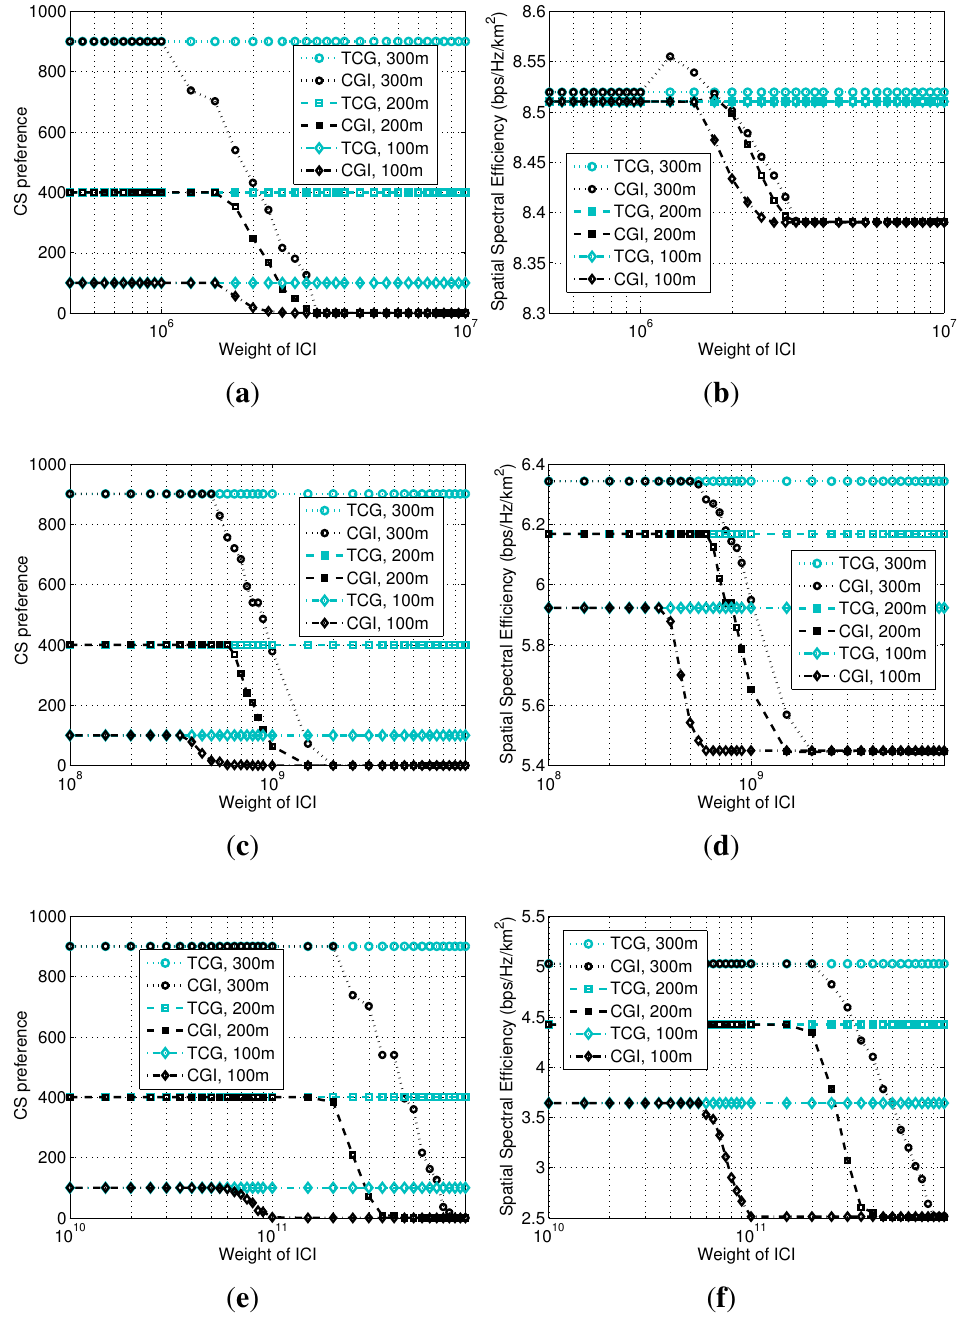
Figure 6. Impact of ICI on CS preference and spatial spectral efficiency using TCG and the congestion game with ICI (CGI). ( a ) Path Loss 2 (free space); ( b ) Path Loss 2 (free space); ( c ) Path Loss 3 (suburbs); ( d ) Path Loss 3 (suburbs); ( e ) Path Loss 4 (downtown); ( f ) Path Loss 4